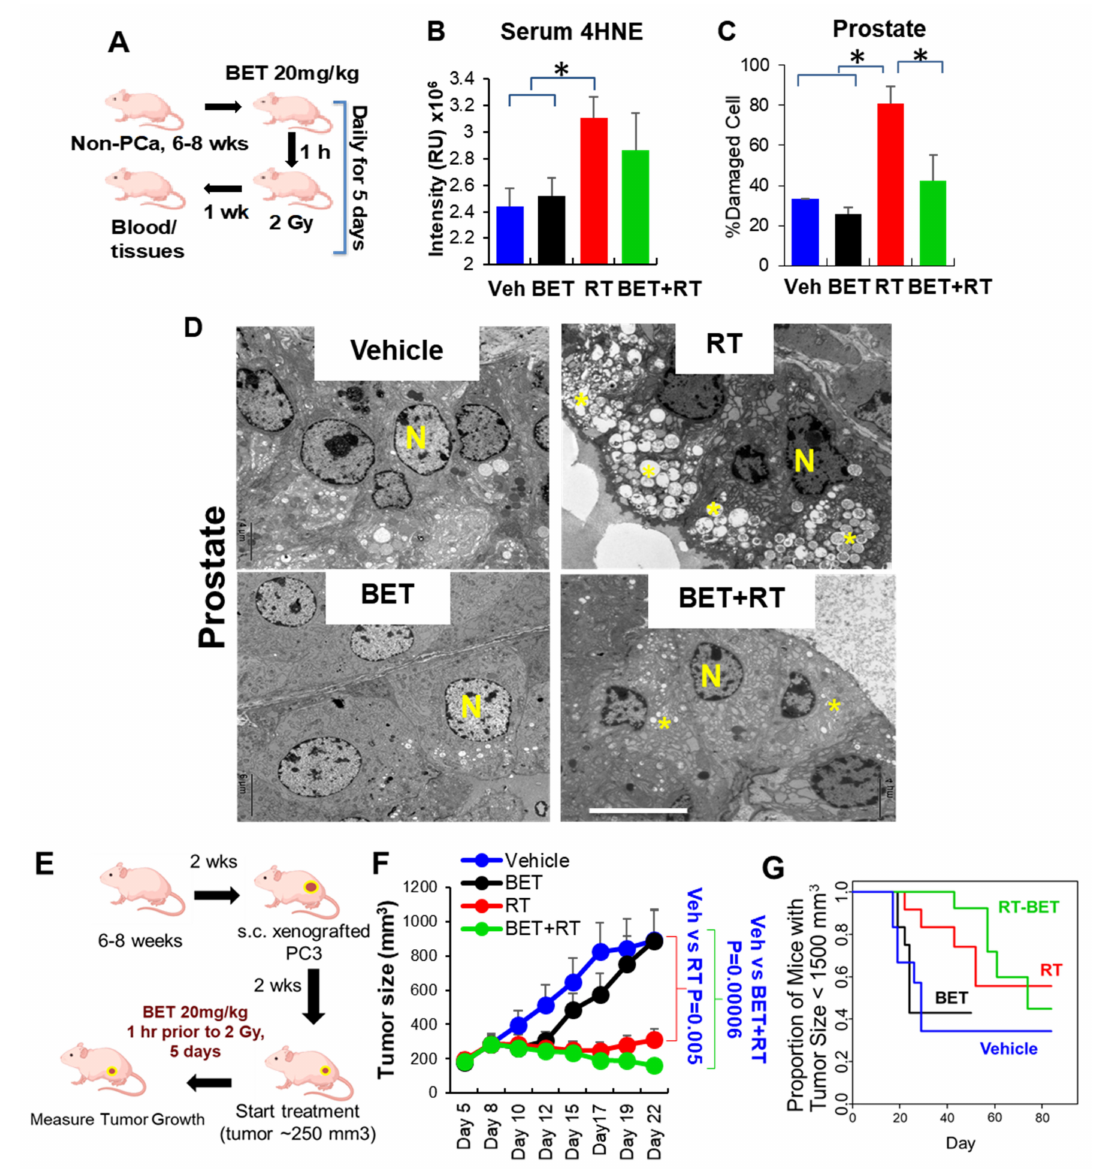
Figure 3. Repurposing BET as a radioprotector for normal tissues while enhancing radiation efficacy for PCa in vivo. ( A ) Non-cancer nude mice were I.P. with BET alone or RT (2 Gy) 1 h prior, daily, for 5 days. Prostate, rectum, and blood were collected 1 week after treatment was completed. n = 5/group. ( B ) 4HNE protein adducts in serum. RU = Relative arbitrary unit. ( C ) Ultrastructural analysis of damaged prostate. ( D ) Representative photographs of damaged prostate. n = Nucleus. Star = Damaged mitochondria as indicated with loss of cristae and vacuolization of mitochondria. Bar = 6 µ m. ( E ) PC3 xenograft tumor mice were I.P. with BET alone or RT (2 Gy) 1 h prior, daily, for 5 days. n = 10/group. ( F ) PC3 tumor size was measured every 2–3 days. ( G ) Survival fraction of PC3 xenograft tumor mice. * p -value ≤ 0.05 when compared to